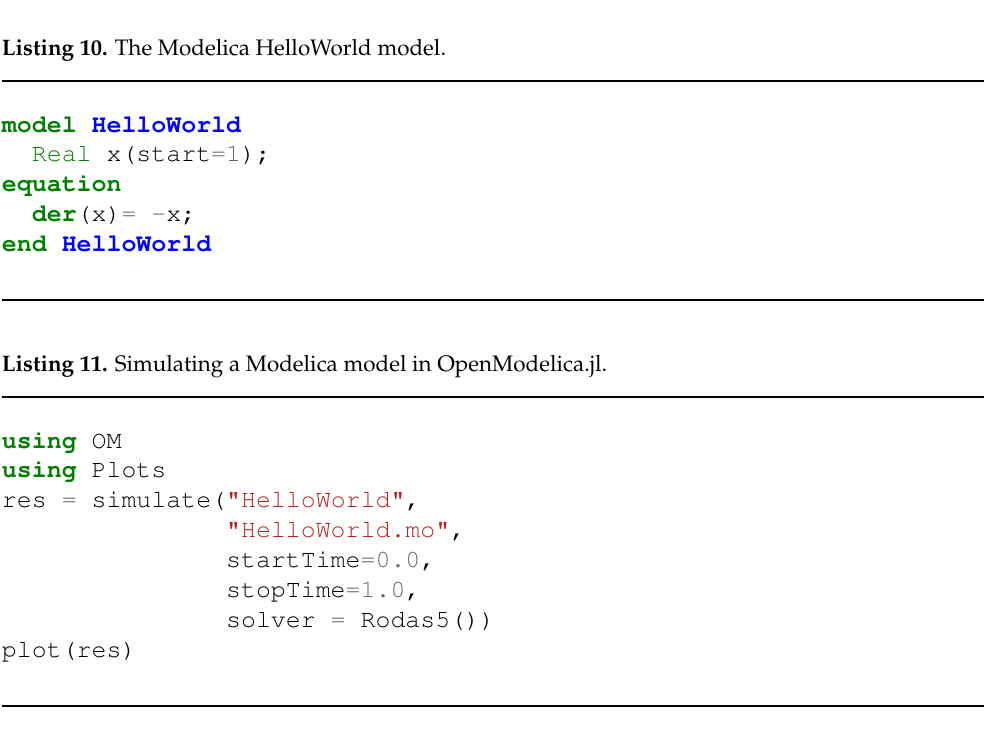
Figure 4. A mapping of the compiler components in OpenModelica.jl to a modern compiler architec- ture. OMParser.jl is responsible for parsing and lexing, OMFrontend.jl is responsible for semantic analysis and optimization of the high-level intermediate representation (HIR). Finally, OMBackend.jl performs the final code optimization and generation. This figure is adapted from ([45], p. 8). Using all of these components we can construct OpenModelica.jl, our Modelica com- piler. For an illustration on how to use the compiler framework to simulate the Modelica HelloWorld model (Listing 10), see Listing